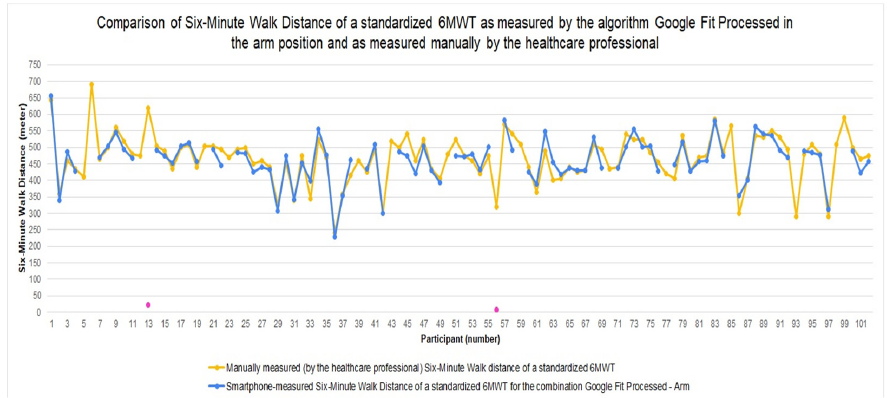
Figure 2. Six-minute walk distance for the standardized 6MWT as measured manually by the healthcare professional, and as measured by the algorithm Google Fit Processed with the smartphone in the arm